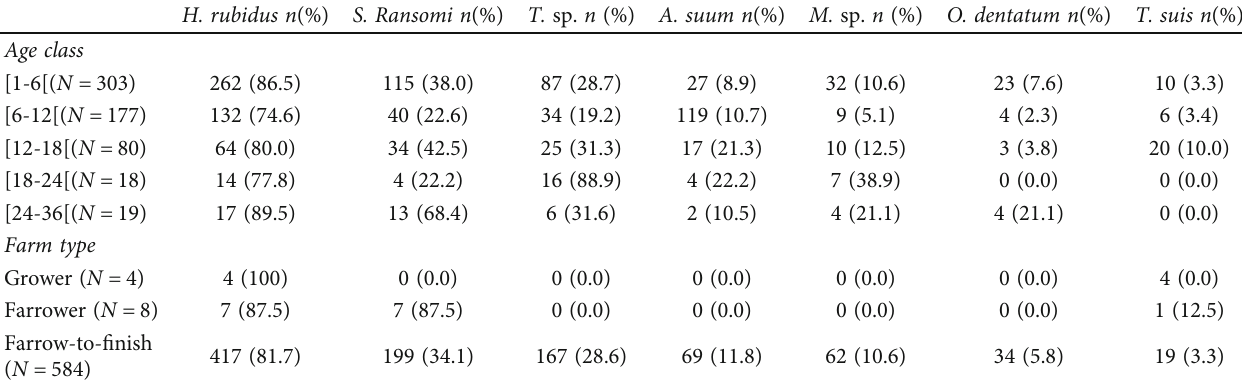
Table 2: Helminth infestation according to age class (month) of pigs and farm type in